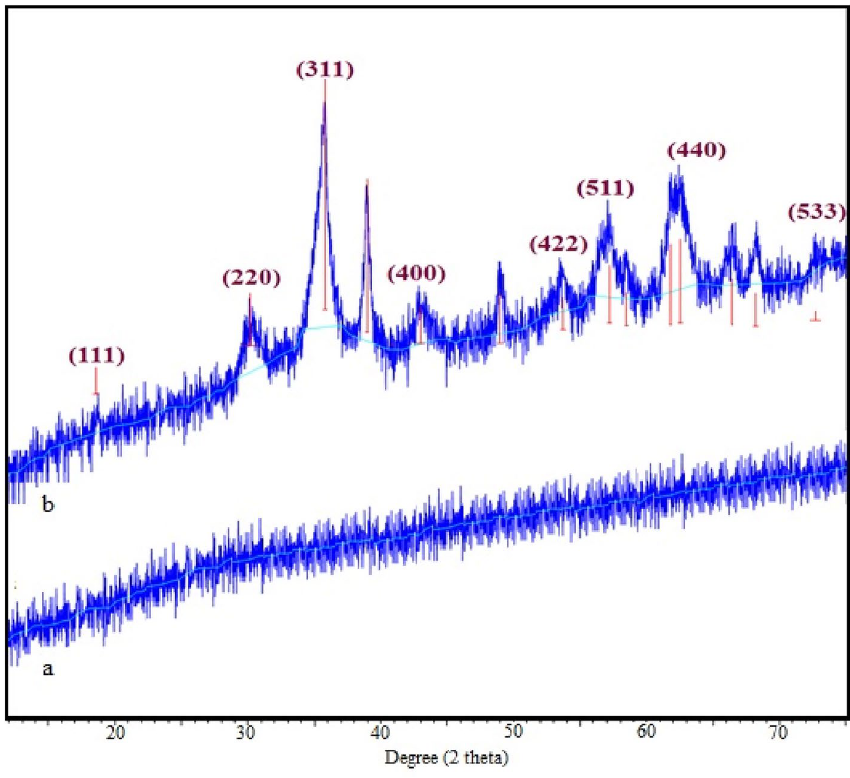
Figure 1. XRD diagram of plant extract ( a ) and Zn-doped CuFe 2 O 4 NPs ( b